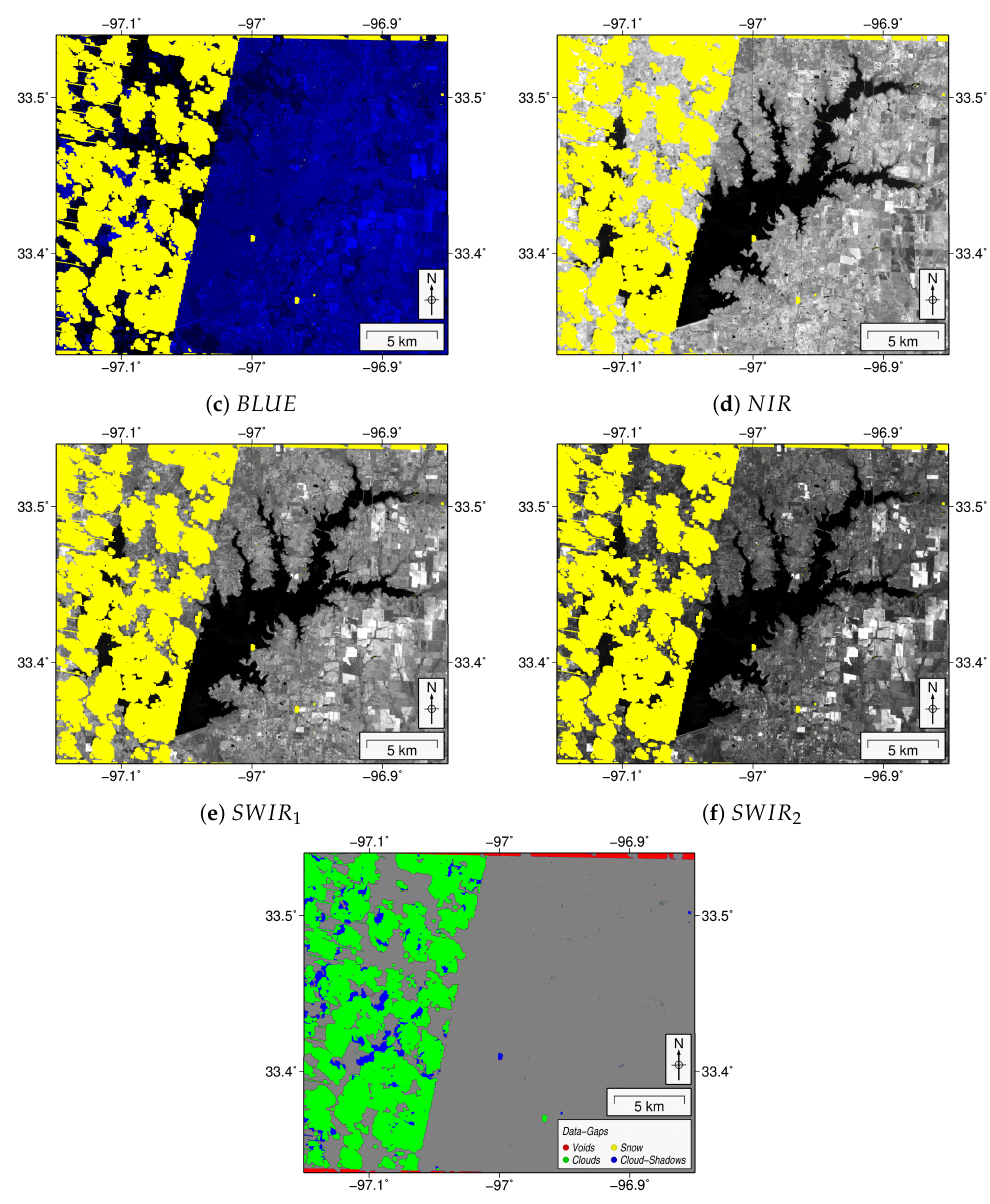
Figure 5. Combined Landsat and Sentinel-2 bands ( RED , GREEN , BLUE , NIR , SWIR 1 , SWIR 2 ) and QUALITY mask (voids, clouds, cloud shadows, snow) used for the computation of indexes for Lake Ray Roberts in April 2016. Data gaps in the Figure 5a–f are highlighted in